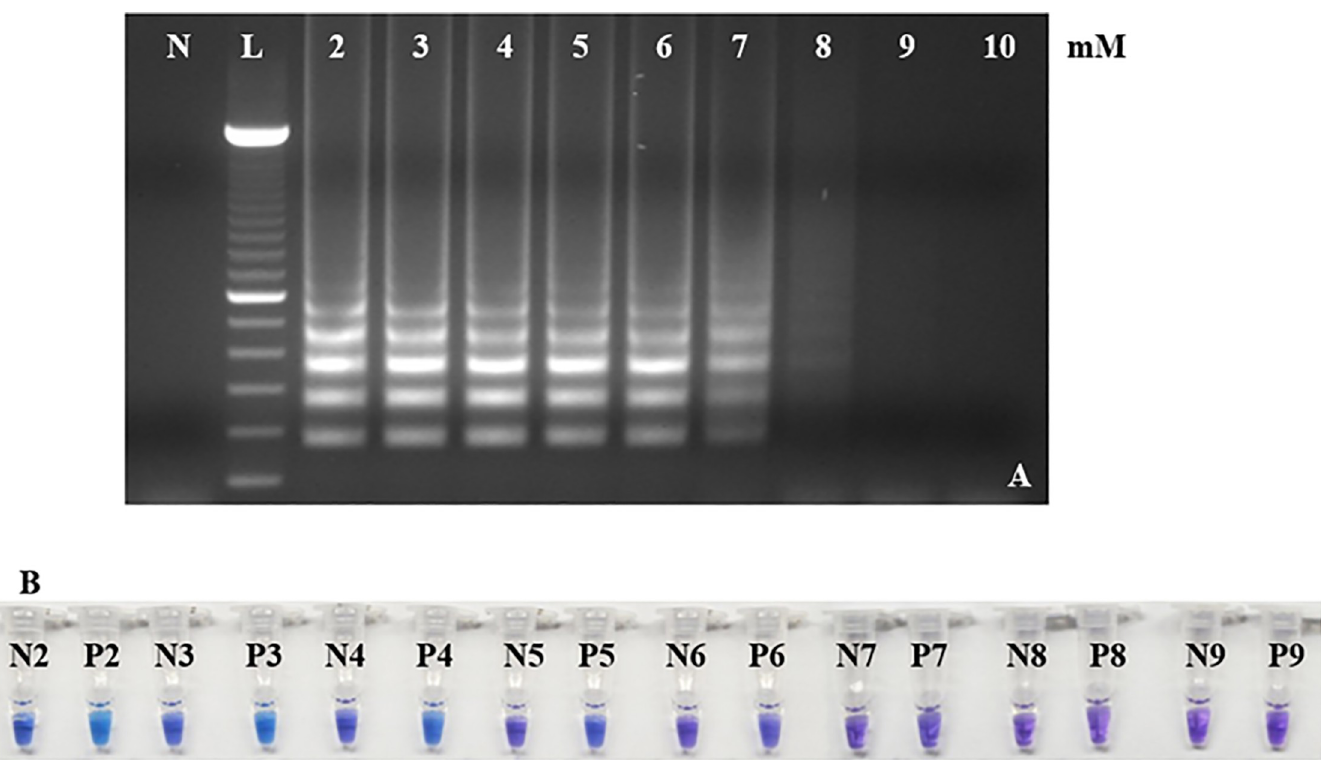
Fig 4. Effect of different concentrations of MgSO 4 in RRV-P3 RT-LAMP using Bst 2.0 DNA polymerase. RRV-P3 and RRV-P4 RT-LAMP results are equal. (A) Gel electrophoresis of RRV-P3 RT-LAMP products. Lane 2 is 2 mM, 3 is mM, 4 is mM, 5 is 5mM, 6 is 6mM, 7 is 7 mM, 8 is 8 mM and 10 is 10 mM. Lane N, is a non- template control (NTC, water); lane L, is a 100 bp DNA ladder. The effect of MgSO 4 concentrations in RRV-P4 LAMP was equal. (B) P tubes are RRV-P3 plasmid (1 ng/ μ L). P2 to P9 are colorimetric HNB reactions. Tube P2 is 2 mM, P3 is 3mM, P4 is 4 mM, P5 is 5 mM, P6 is 6 mM, P7 is 7 mM, P8 is 8 mM, and P9 is 9 mM. N tubes are non-template controls (NTC, water). Tube N2 is 2 mM, N3 is 3mM, N4 is 4 mM, N5 is 5 mM, N6 is 6 mM, N7 is 7 mM, N8 is 8 mM, and N9 is 9